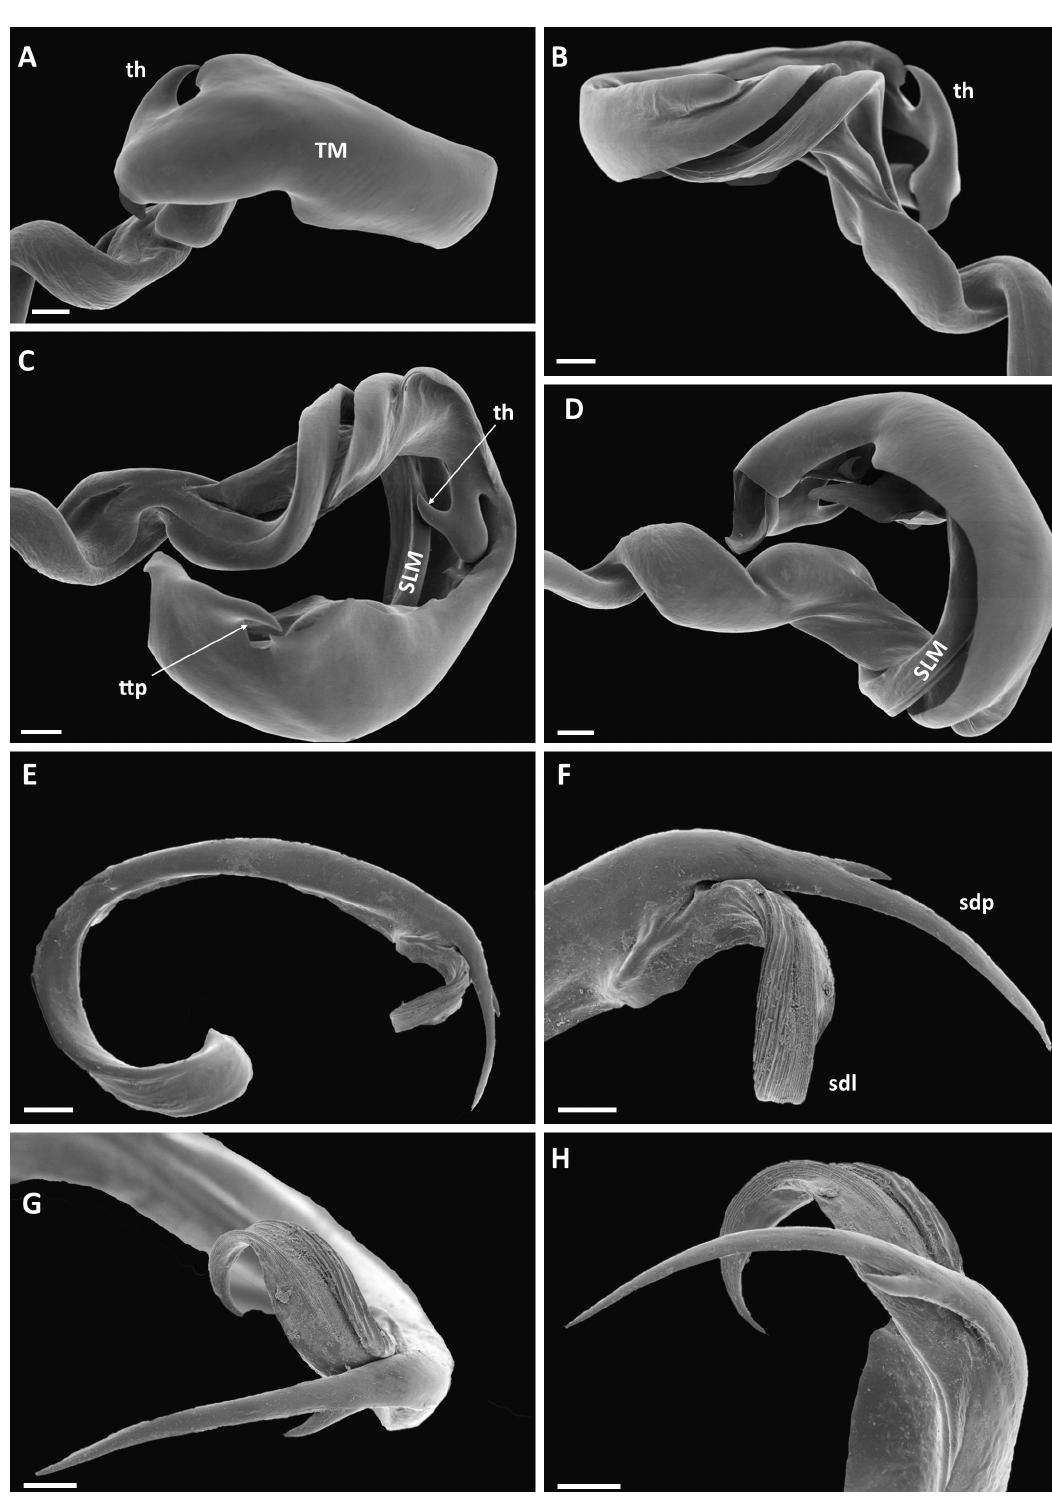
Fig. 64. Xystopyge bentemarieae sp. nov. A–D . Holotype, ♂ (NHMD 621766), left gonopod telopodite. A. Anterior view. B. Posterior view. C. Dorsal view. D. Ventral view. E–H . Paratype, ♂ (NHMD 621767), isolated solenomere. Abbreviations: sdl = solenomeral distal microstriate branch; sdp = solenomeral distal spinelike branch; SLM = solenomere; th = telomeral hook; TM = telomere. Scale bars: A – E = 0.1 mm; F – H = 0.05